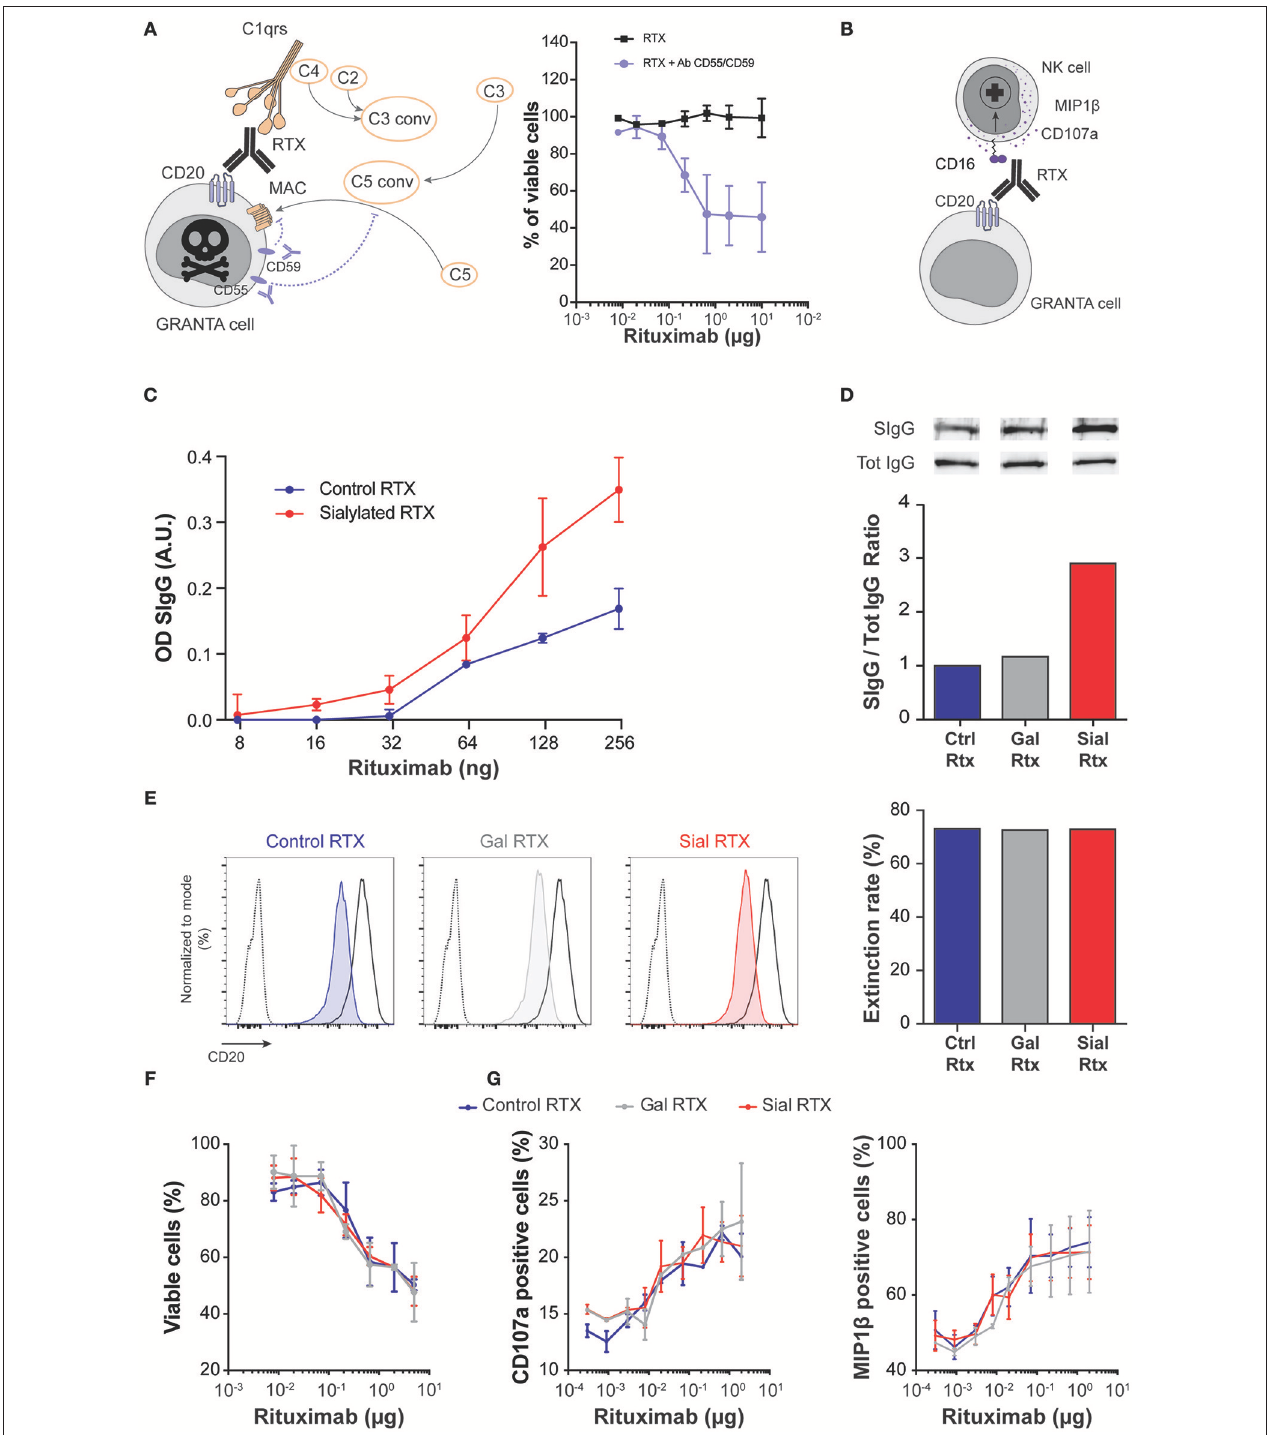
FIGURE 5 | Sialylation of Fc fragment does not modify IgG function. (A,B) Schematic representation of the experimental models used to assess the ability of the human monoclonal IgG1 rituximab (RTX) to trigger complement-dependent cytotoxicity (A) and antibody-dependent activation of NK cells (B) . Complement-dependent cytotoxicity assay (A) with human serum required blocking the surface regulatory proteins CD55 and CD59, which prevent the terminal